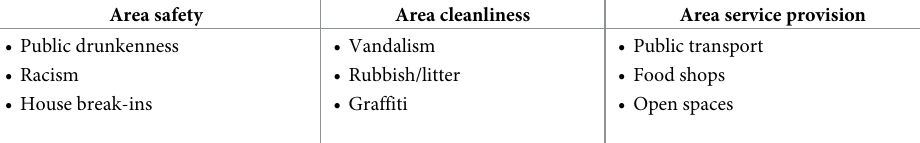
Table 2. Grouping of variables capturing perceptions of area-level